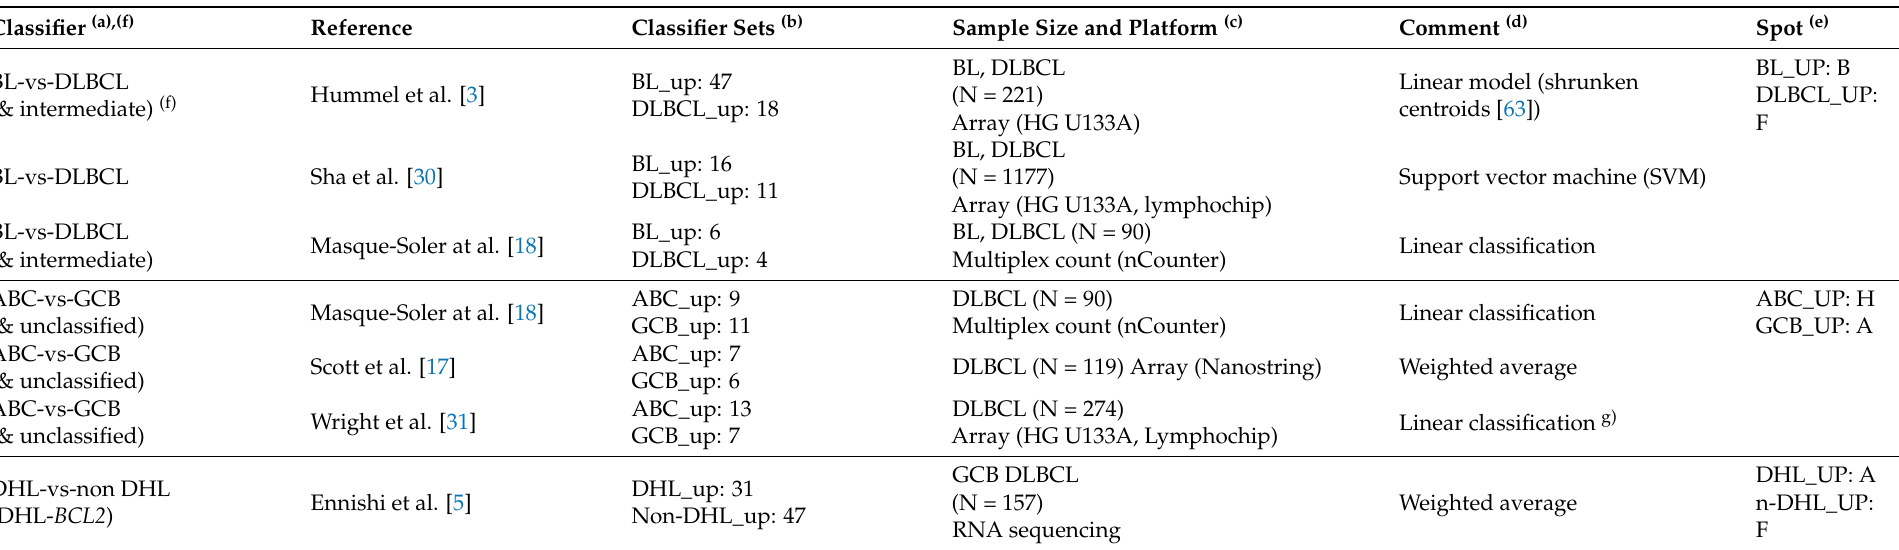
Table 2. Classifier signatures used for evaluation. An interactive classifier tool is implemented in the opoSOM browser (Appendix B and [62] for a short